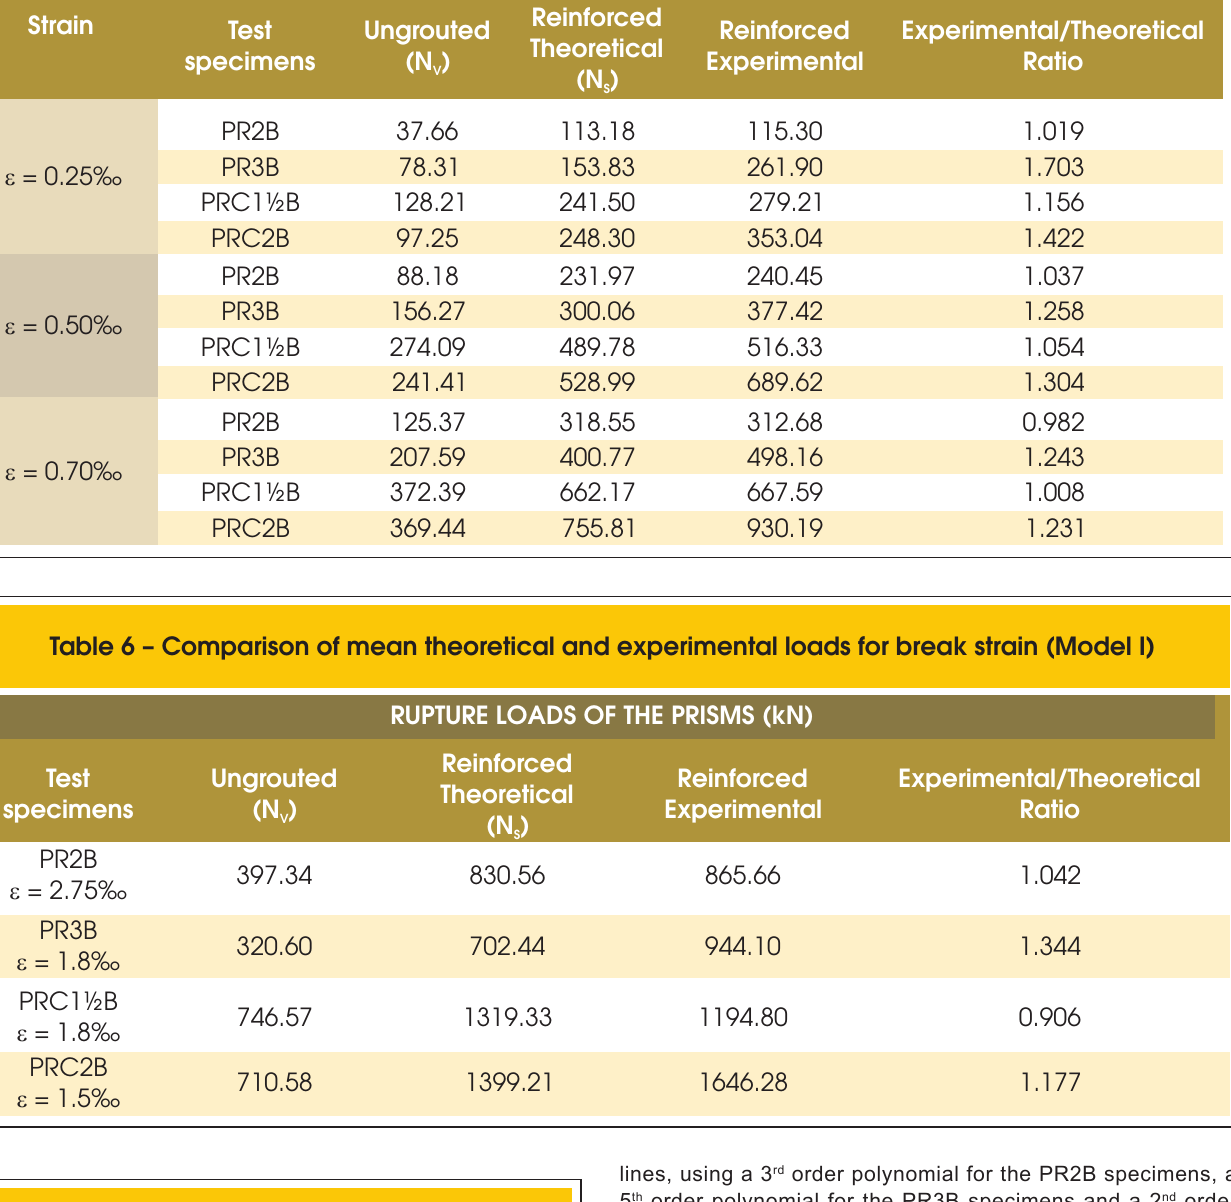
Figure 15 – Stress - strain diagram with a tendency line to estimate the